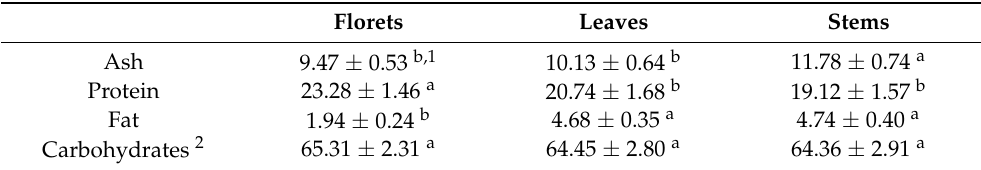
Table 4. The proximate composition of the aerial parts of cauliflower, expressed in %, as the mean ± SD ( n =